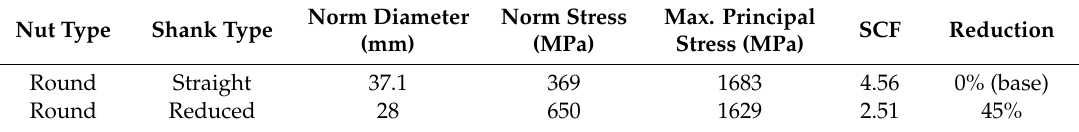
Table 9. Bolt shank effect on SCF (connected with round nut type).